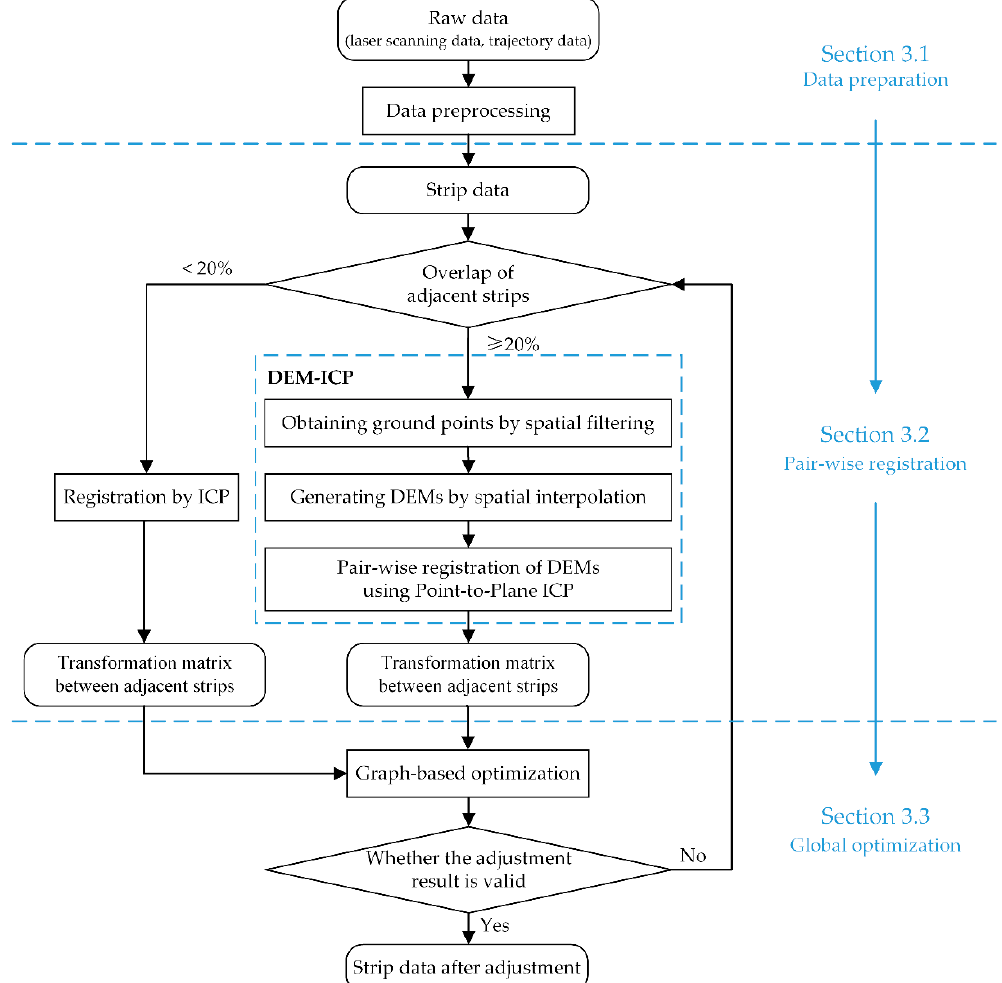
Figure 1. The workflow of the proposed method. Table 1. Some of the symbols used in this section and their brief descriptions.